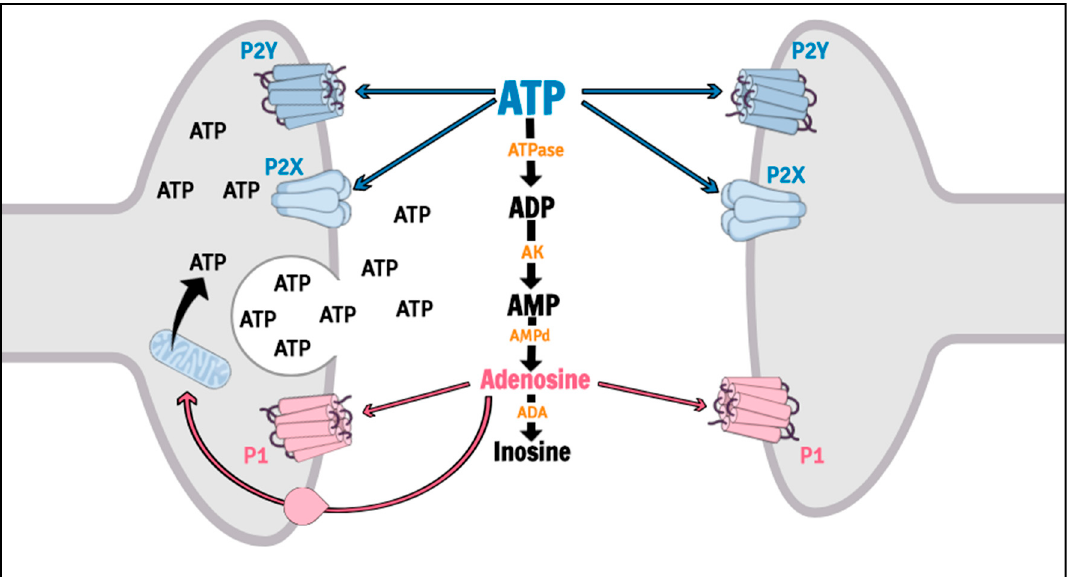
Figure 2. Purinergic signaling. ATP is synthesized in terminal nerves, glial cells or astrocytes by mitochondrial oxidative phosphorylation, and released to extracellular space after physiological or pathological stimulus by vesicular exocytosis, transmembrane channels (pannexin, connexin) or cellular apoptosis. Extracellular ATP may either interact with P2 receptors or be rapidly metabolized to adenosine. P2 receptors are divided in P2X (cation ionotropic) and P2Y (metabotropic) receptors. Adenosine molecules may interact with P1 receptors (metabotropic), they can be reuptaken and converted back into ATP in cell cytoplasm or they can be metabolized by ADA into inosine. ATP: adenosine triphosphate; ATPase: adenosine triphosphatase; AK: adenylate kinase; AMPd: adenosine monophosphate deaminase; ADA: adenosine